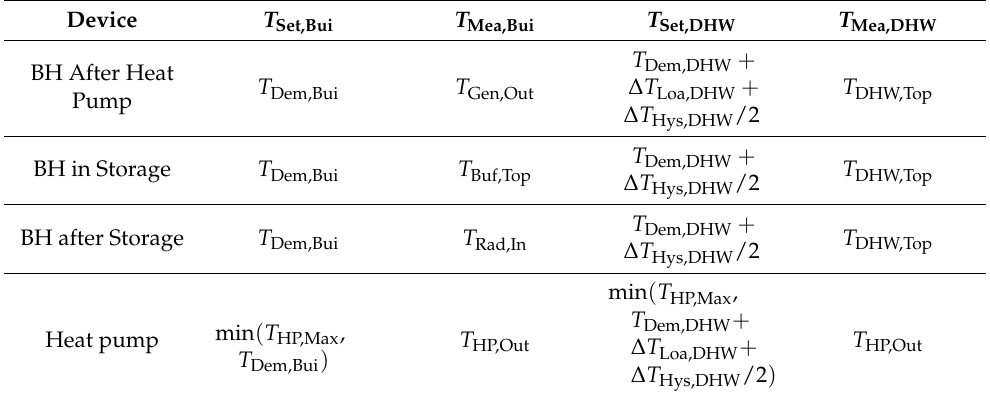
Table 1. Set and measured values for control of space heating and DHW for different placements of back-up heaters and the heat pump. Refer to Figure 1 for the measurement points of stated variables.